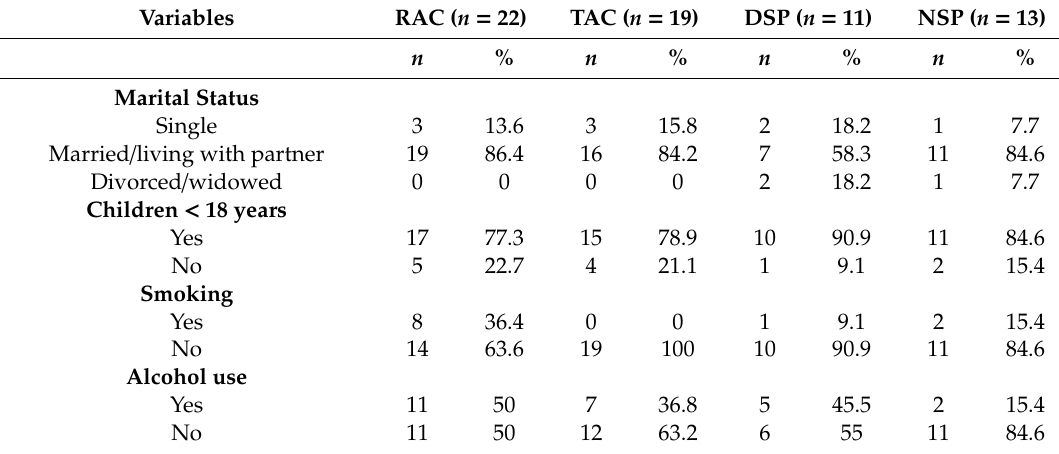
Table 1. Sociodemographic characteristics among rural (RAC), town (TAC), and city (DSP–dayworkers; NSP–night workers)